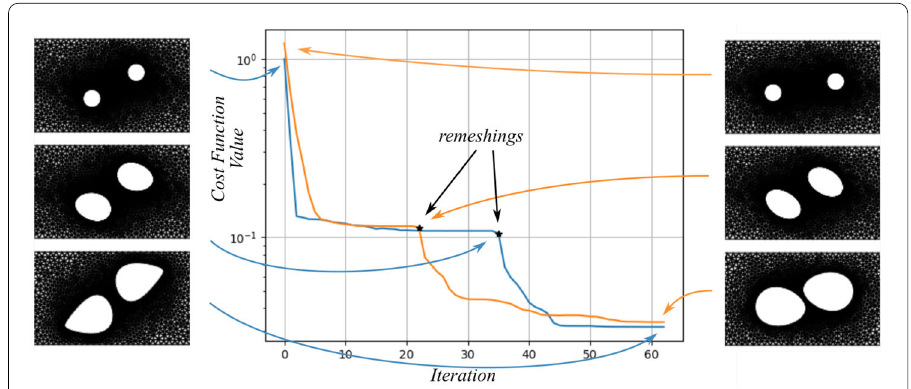
Fig. 18 Example of the orthotropic specimen with two holes: evolution of the cost function value and zooms on the hole shapes during the optimization process (including one remeshing step each) for 2 different initial positions of the holes